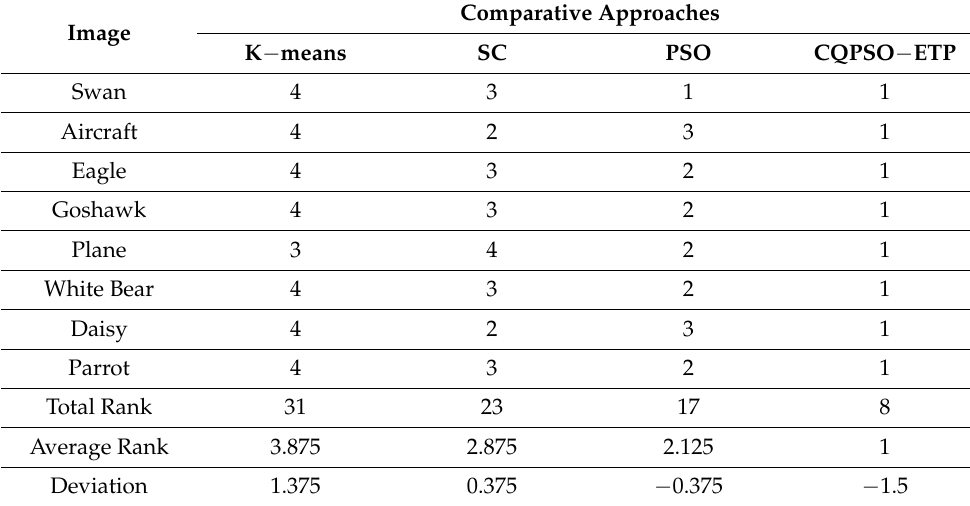
Table 10. Ranks of the average values for four comparative approaches (Mean) and computation of the Friedman test